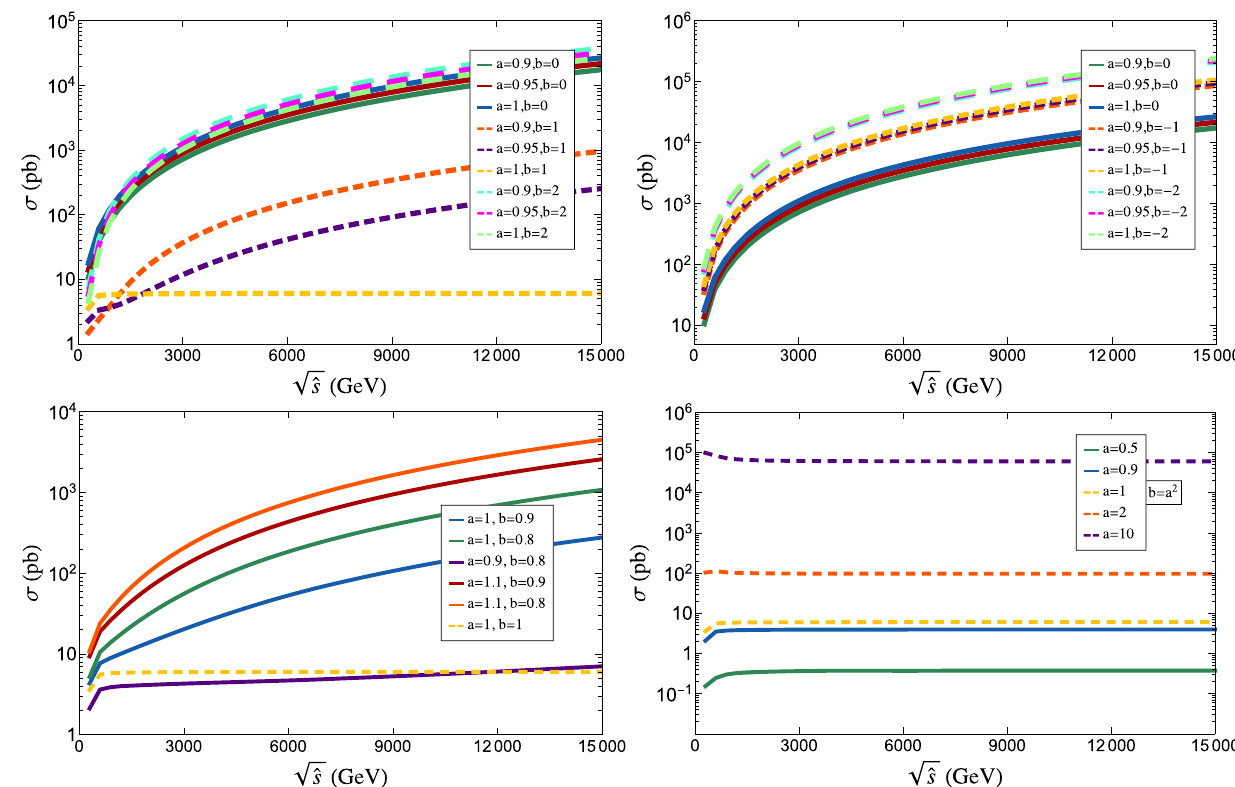
Fig. 8 Total cross sections of the W − W + → H H subprocess in the EChL, as a function of the CM energy, for different values of the param- eters a and b . The upper left (right) panel shows positive (negative) values of b . Smaller deviations of this parameter with respect to b = 1